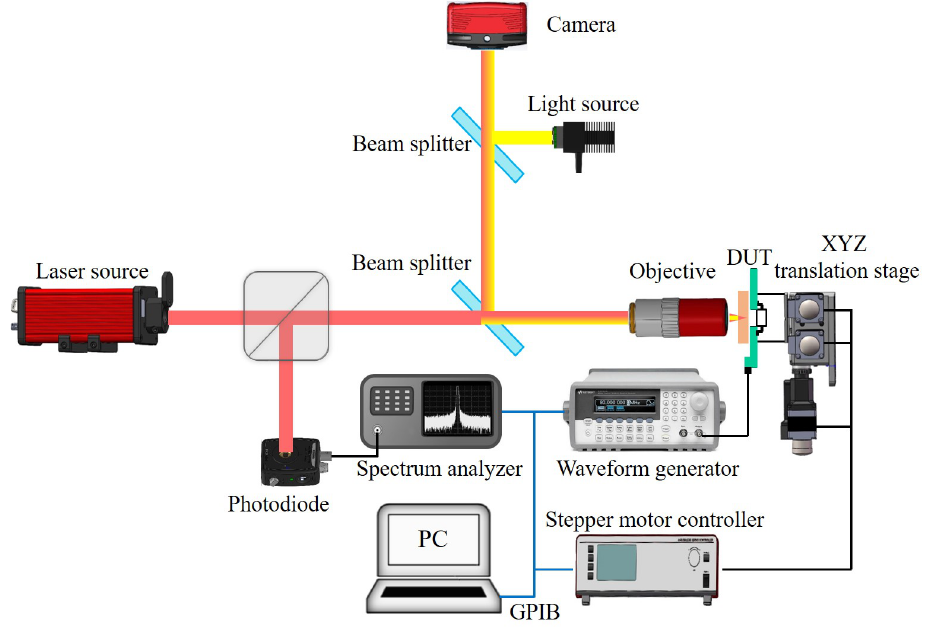
Figure 7. Schematic diagram of the Laser Scanning and Mapping System.